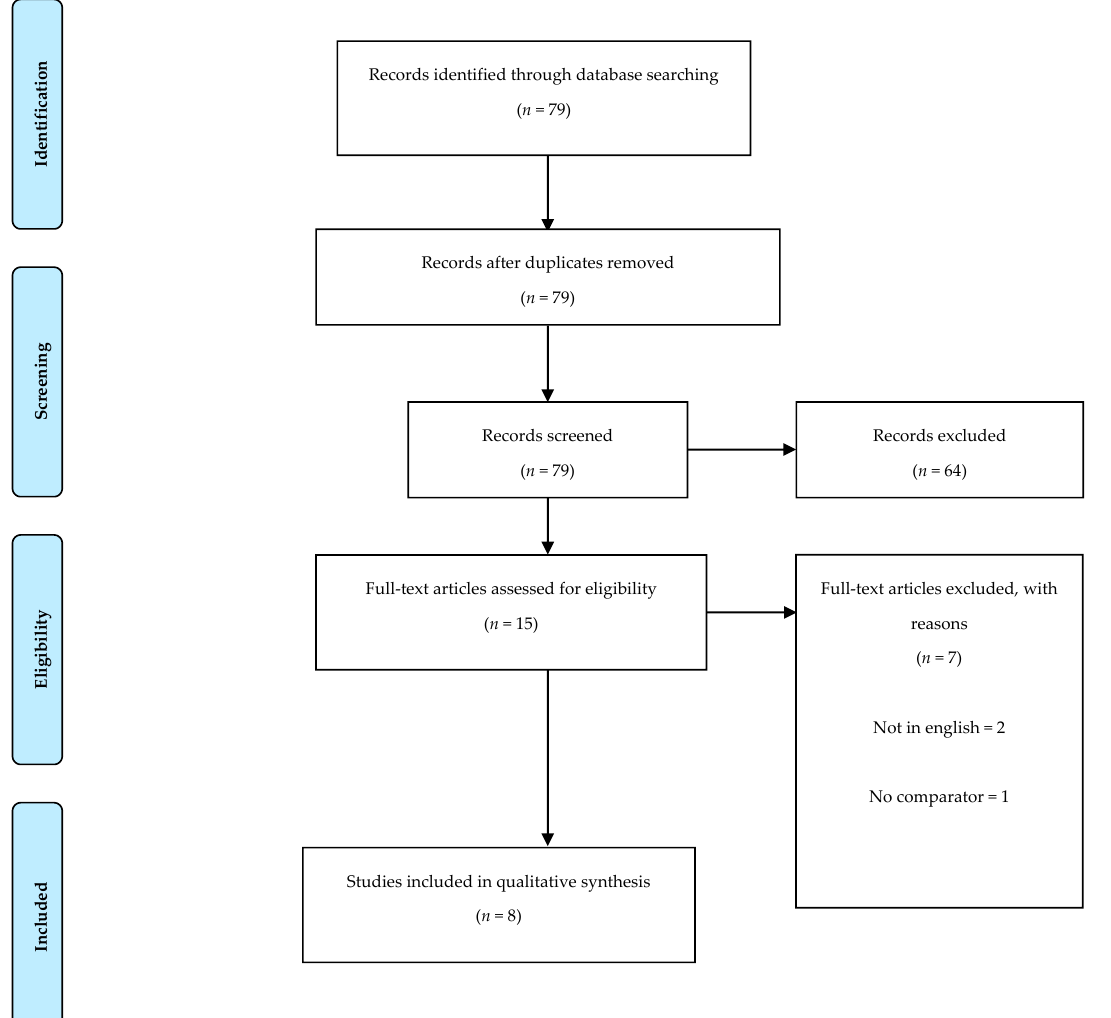
Figure 1. PRISMA flow diagram highlighting the selection process for the studies included in the current systematic review.